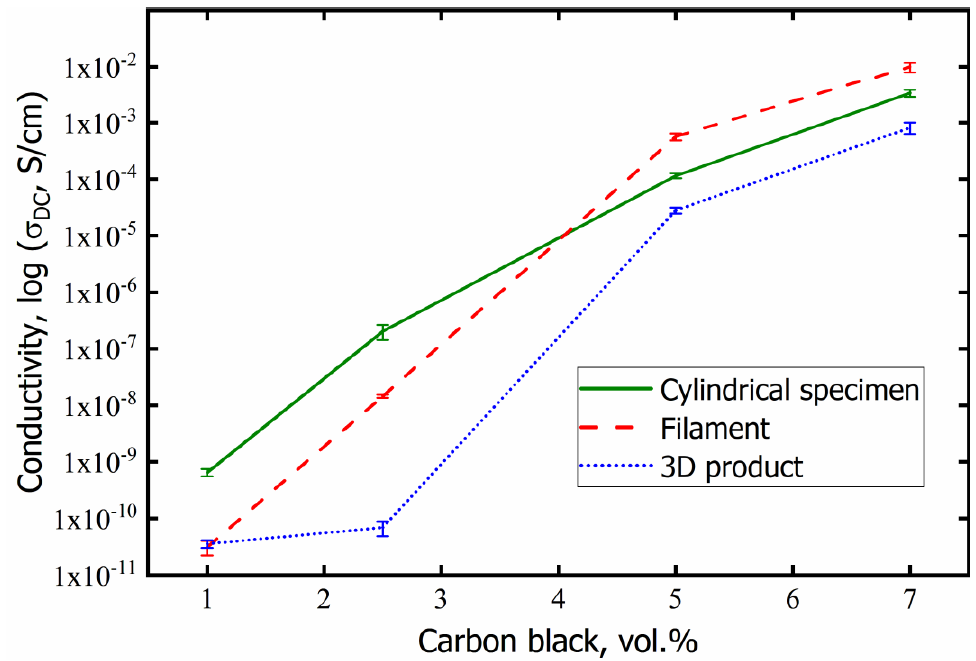
Figure 14. Dependences of electrical conductivity σ dc of specimens on the CB content.